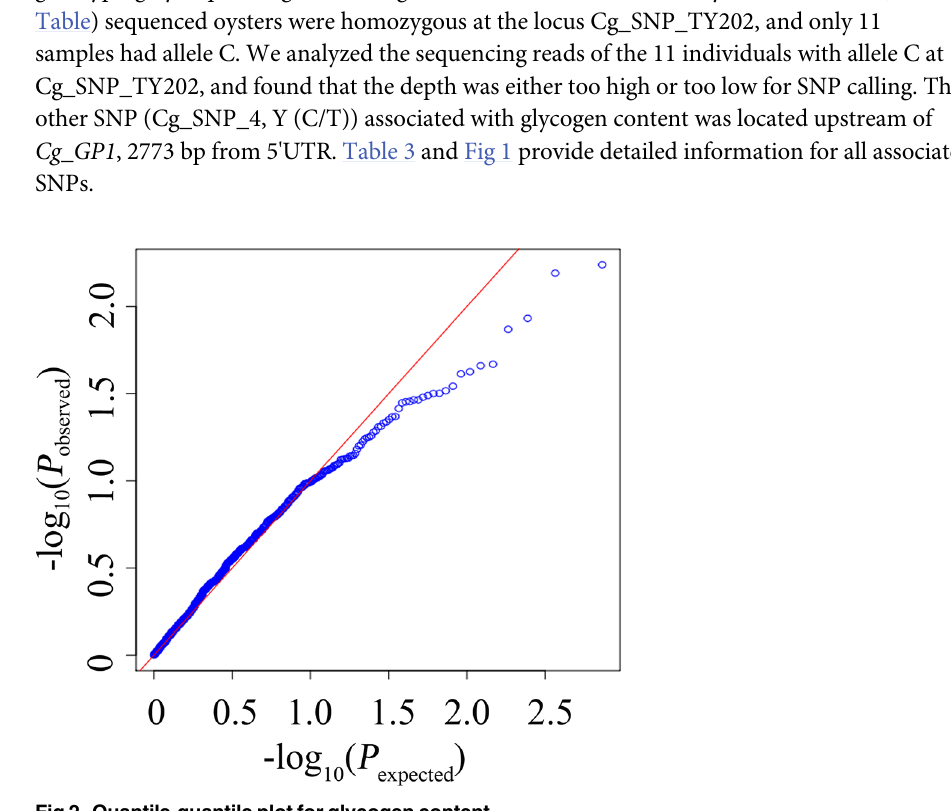
Fig 2. Quantile-quantile plot for glycogen